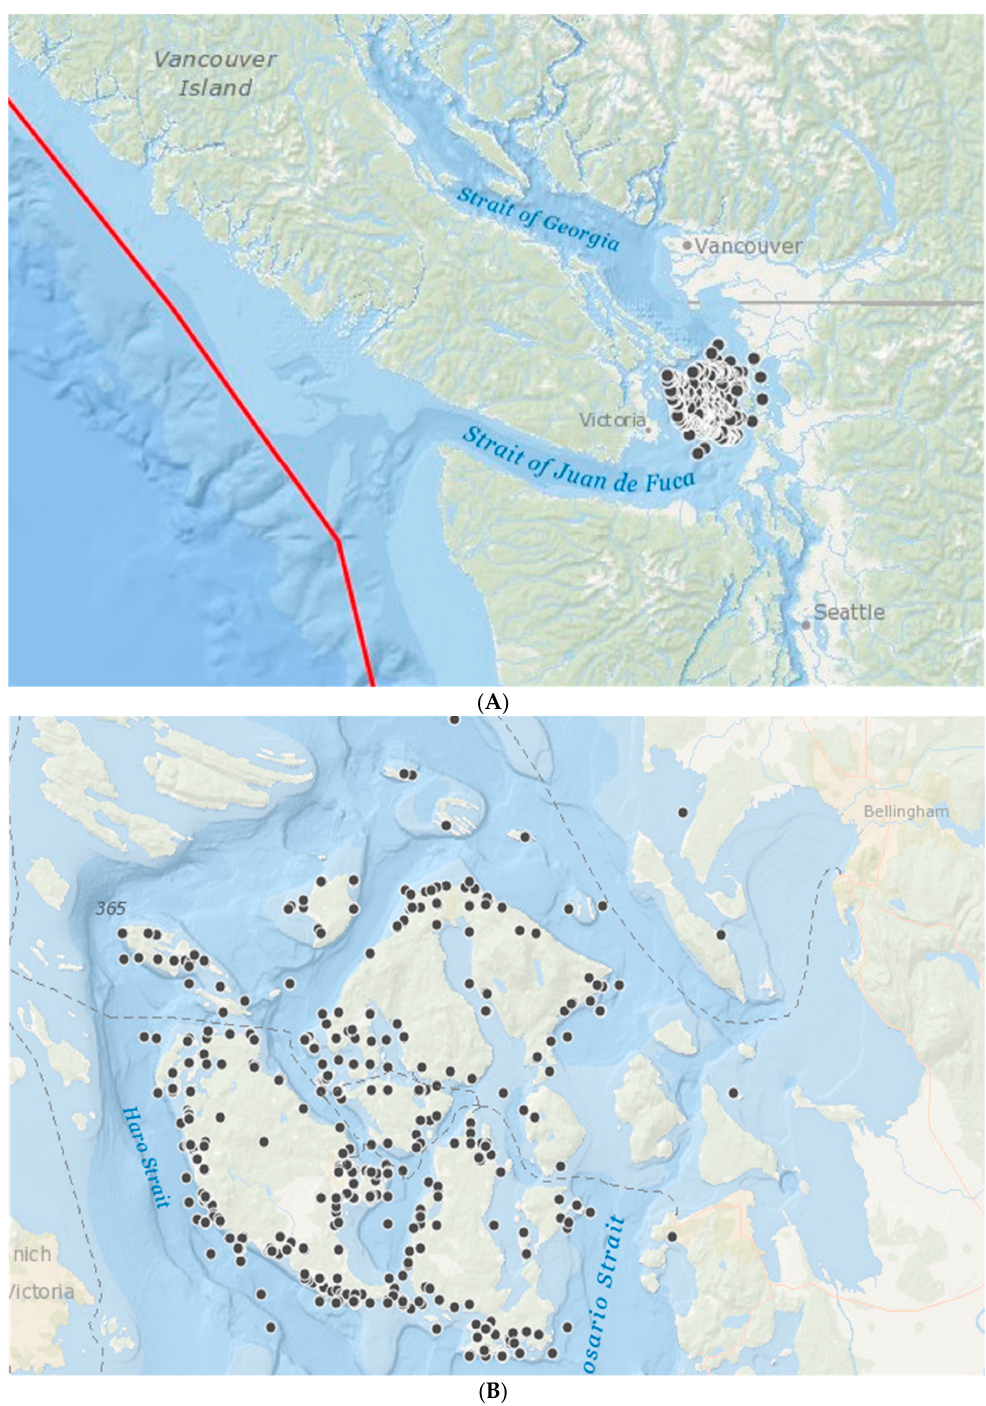
Figure 3. The black dots show the location of marine mammal stranding or mortality events collected by the San Juan County Marine Mammal Stranding Network between 2005 and 2010. ( A ) showing the location of the convergent plate boundary (red line); ( B ) showing detail of the San Juan Islands. Map produced in ARCGIS online (Copyright © 1995–2017 Esri).